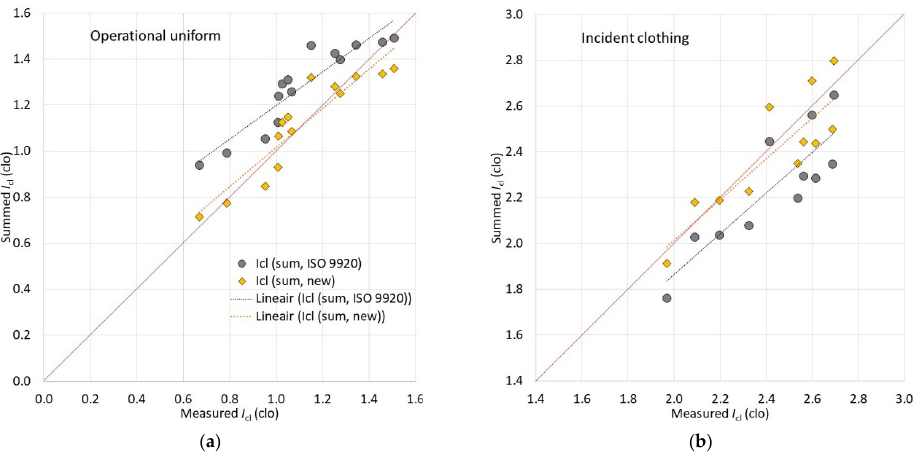
Figure 1. Separate relationships between measured and summed basic clothing insulation ( I cl , clo) for ( a ) operational uniform and ( b ) incident clothing ensembles. Icl (sum, ISO 9920) represents summation according to ISO 9920, and Icl (sum, new) modified the summation for these datasets.